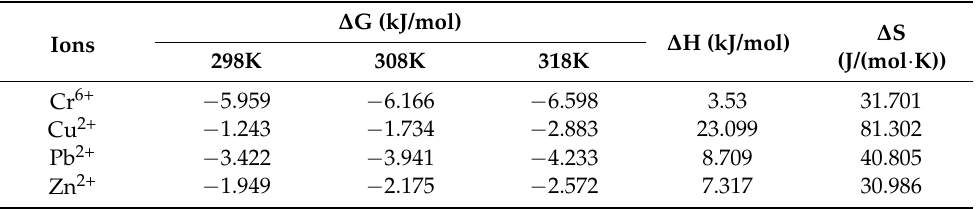
Table 4. Adsorption thermodynamic parameters of Cr 6+ , Cu 2+ , Pb 2+ , and Zn 2+ onto magnetic nano-chitosan in aqueous